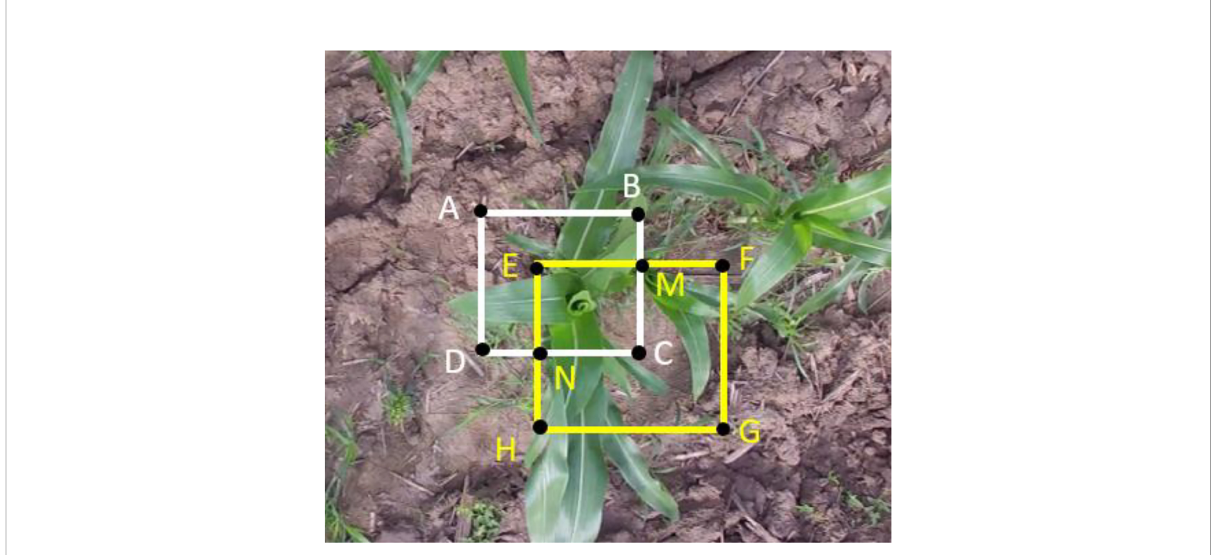
FIGURE 4 The schematic diagram of a maize plant detection and a tracking bounding